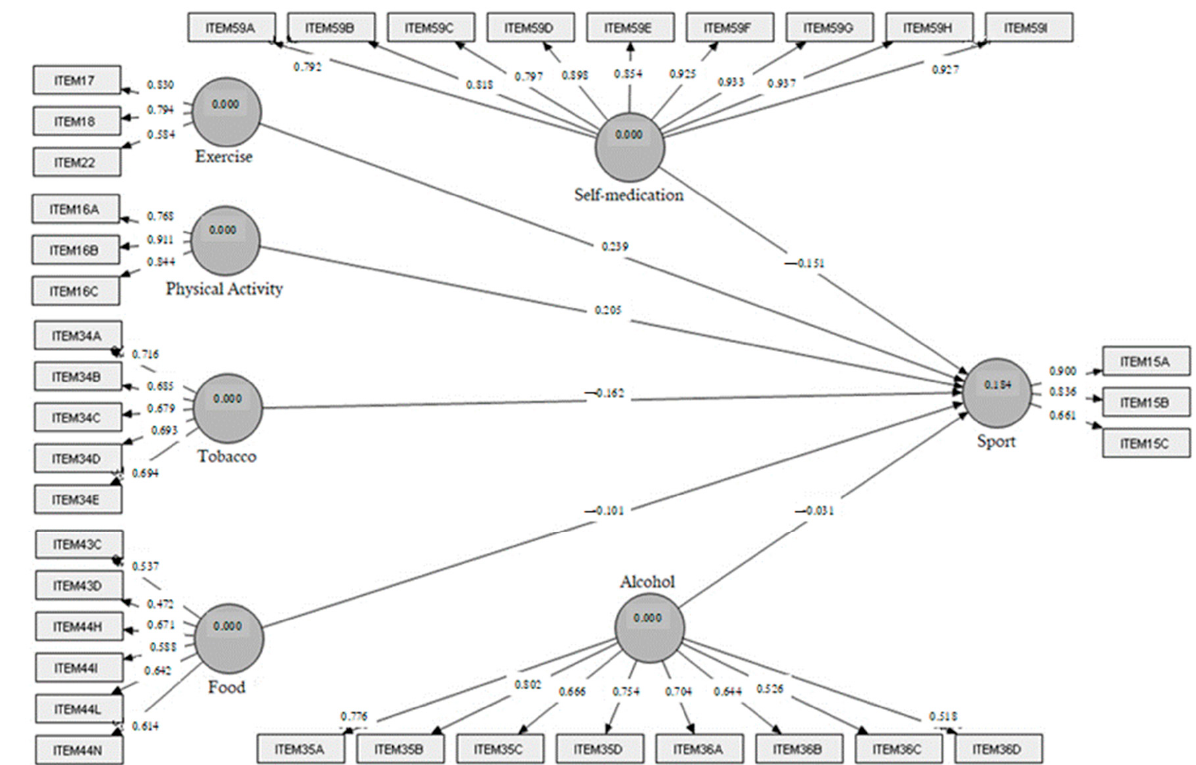
Figure 1. The influence model of healthy habits and sports practice.